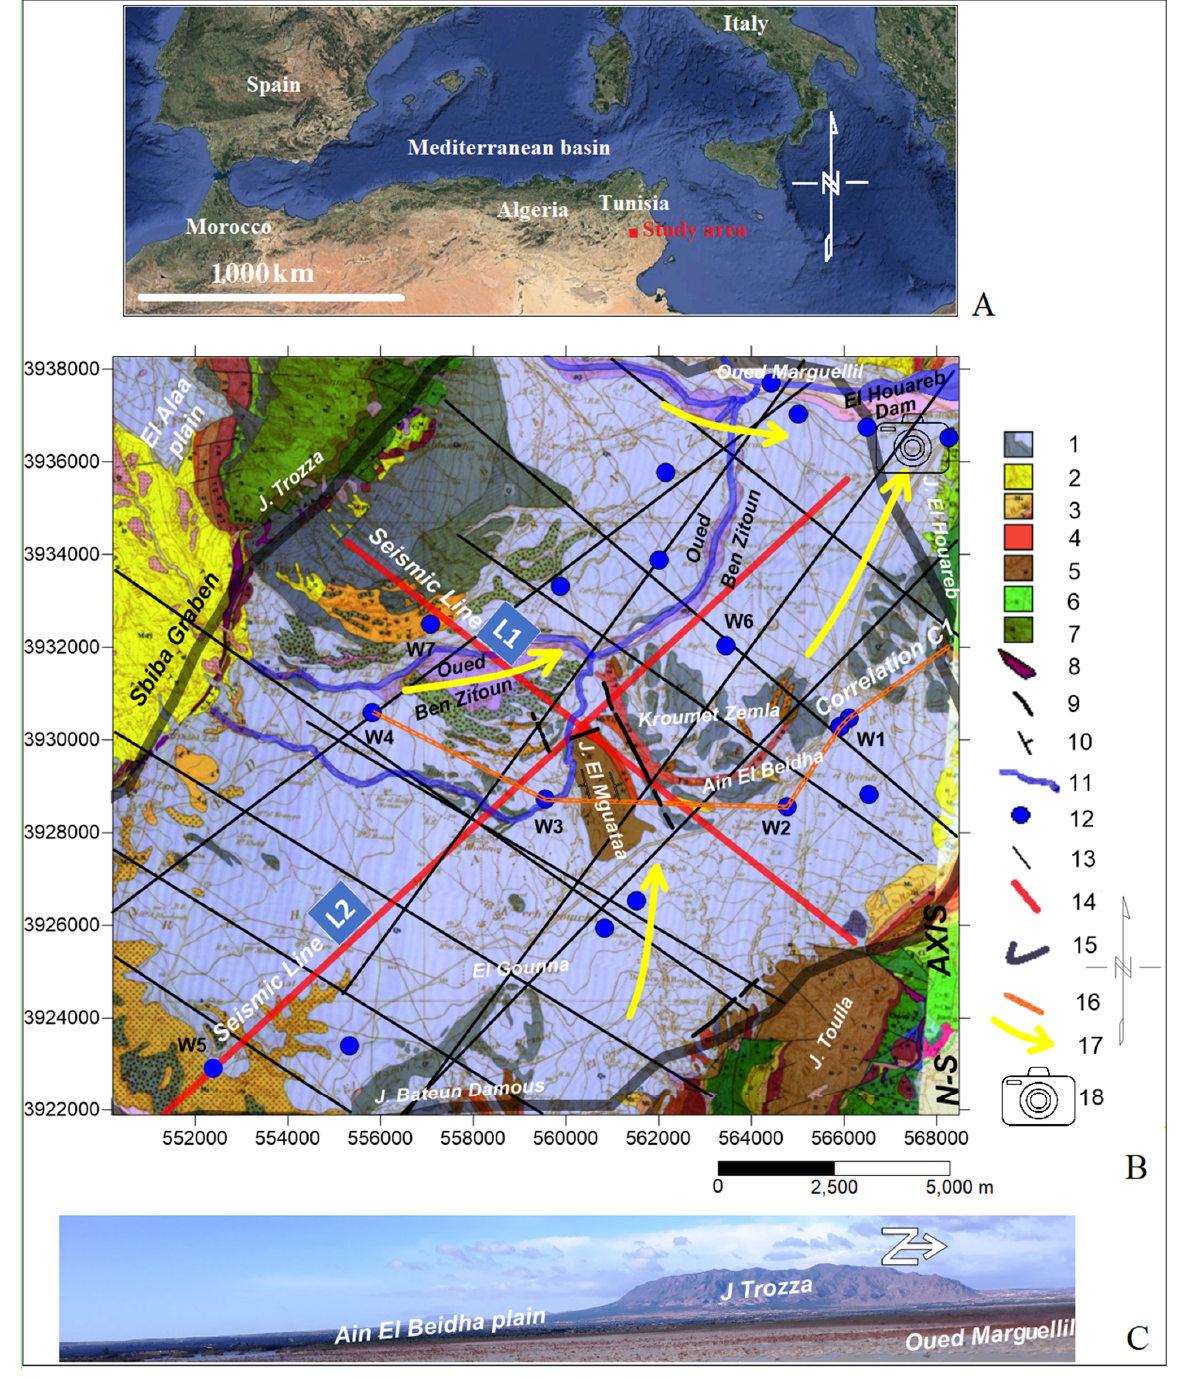
Figure 1. ( A ). Regional situation of Tunisia. ( B ) Geological and hydrogeological setting of the Ain El Beidha plain located in central Tunisia (Geological data adapted from [11,20] UTM projection WGS84 N32. (1) Quaternary and Mio–Plio–Quaternary. (2) Miocene (Sbiba graben). (3) Miocene (Ain El Beidha plain). (4) Oligocene. (5) Eocene. (6) Upper Cretaceous. (7) Lower Cretaceous. (8) Triassic. (9) Major mapped faults. (10) Dip. (11) River. (12) Boreholes. (13) Seismic line. (14) L1 and L2 seismic lines. (15) Limit of 1km*1km used gravity survey. (16) Hydrogeological well correlation. (17) Groundwater flow direction. (Adopted from [19]). (18) Position of the picture. ( C ) General view of the Ain El Beidha plain.